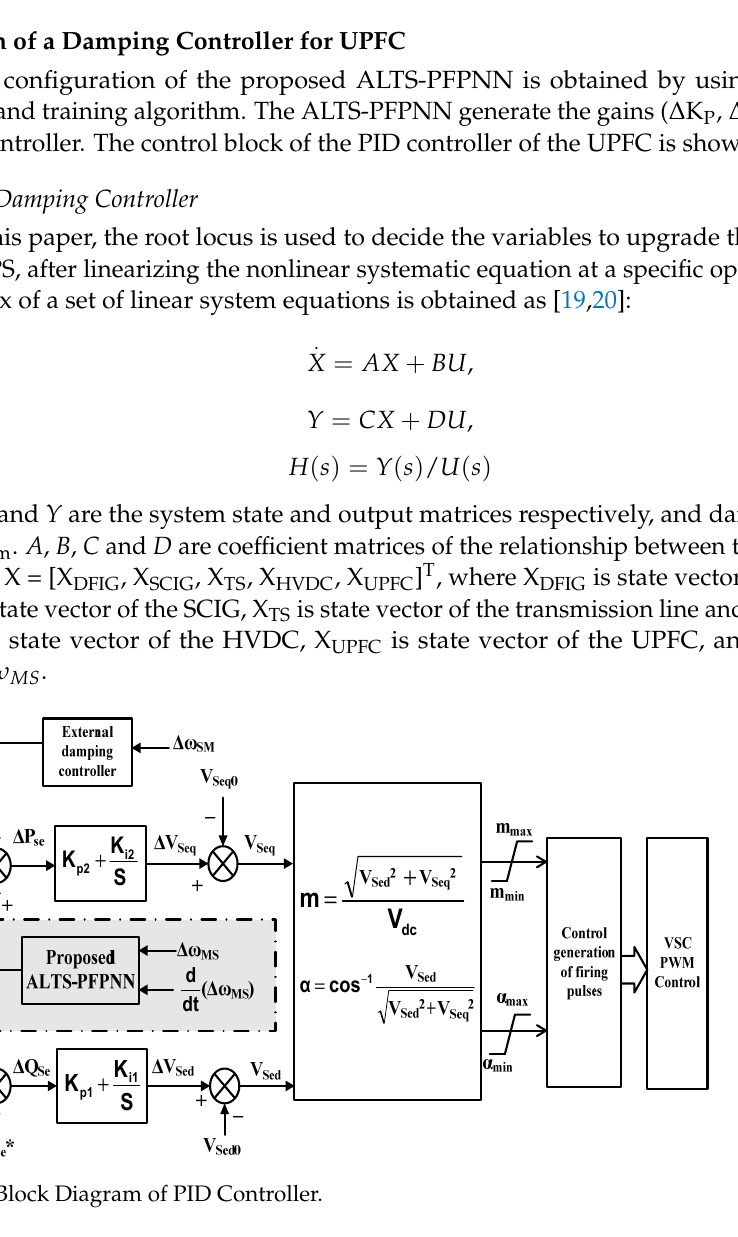
Figure 3. Architecture of UPFC.